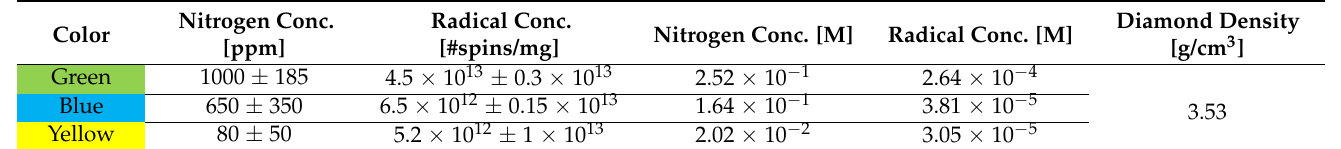
Table 3. Comparison between average nitrogen concentration and carbon-centered radical concentra- tion in the